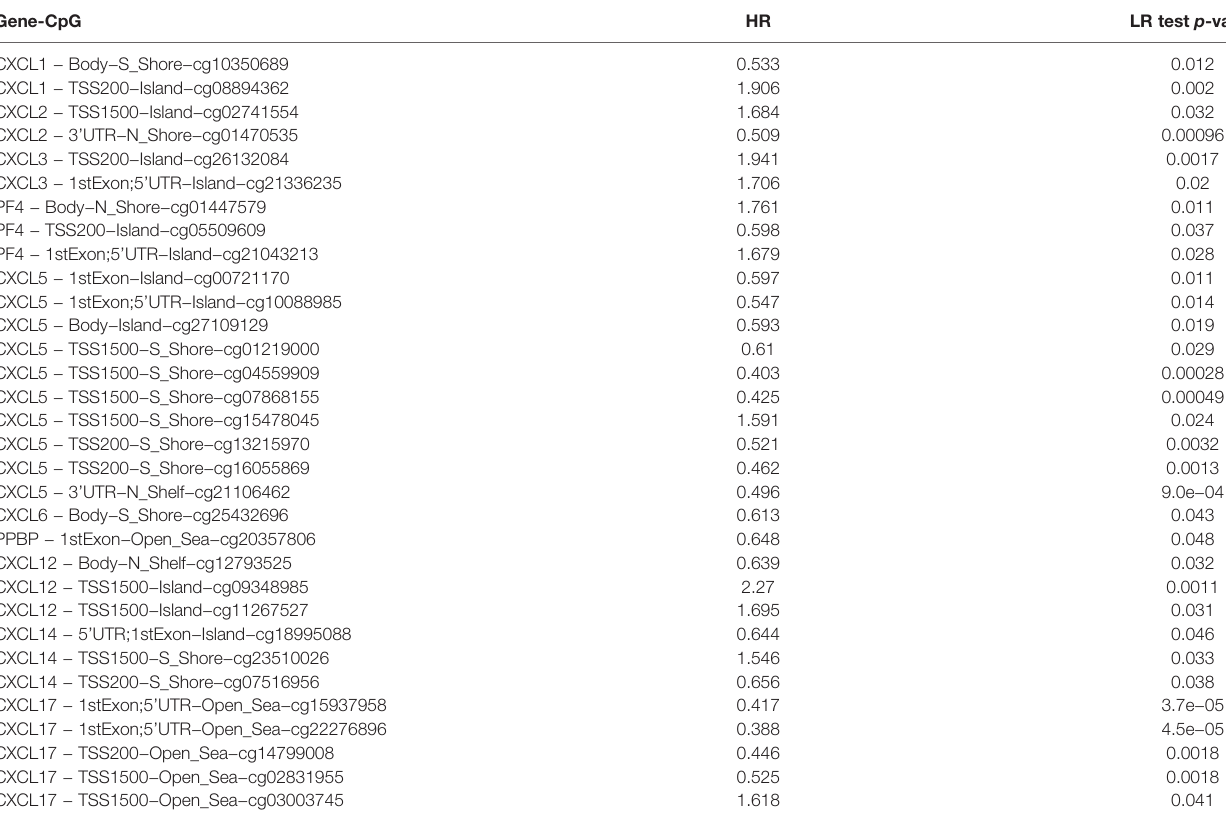
TABLE 6 | The signi fi cantly prognostic value of single CpG of CXC Chemokine in PAAD (MethSurv). Gene-CpG HR LR test p